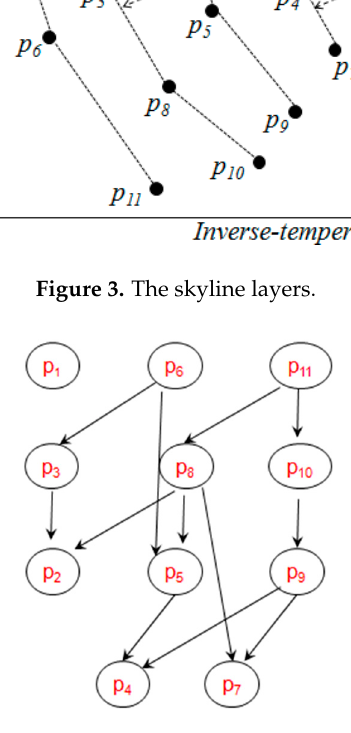
Figure 4. Directed skyline graph.